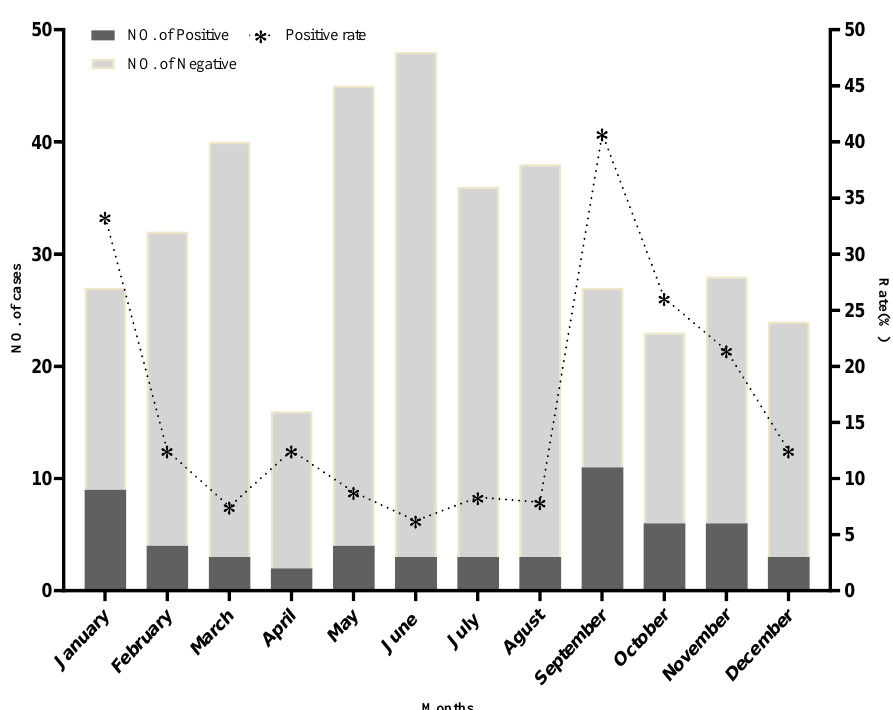
Figure 2. Monthly distribution of human adenovirus infection in hospitalized children under the age of 5 years from Rawalpindi and Lahore Districts, Punjab, Pakistan.